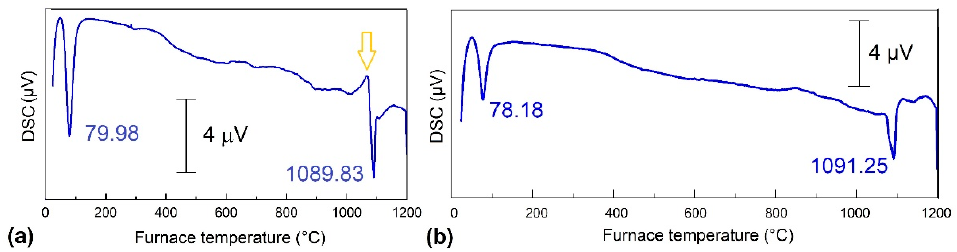
Figure 7. DSC thermograms of fragments cut from tensile-tested opm specimens: ( a ) after failure, according to Figure 3a; ( b ) after four loading–unloading cycles, up to 300 MPa, according to Figure 3b.